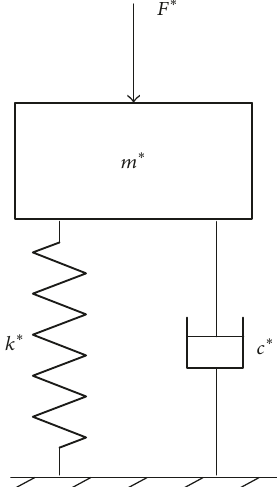
Figure 2: Equivalent SDOF model of the cracked cantilever